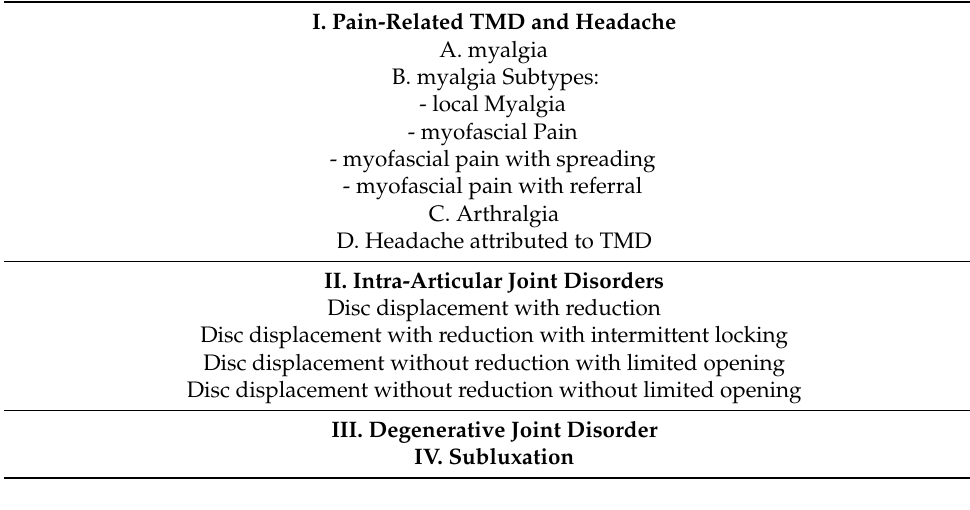
Table 3. Disorders diagnosed according to Axis I and the Decision Tree (DC/TMD) in the differential diagnosis of TMD MPS.